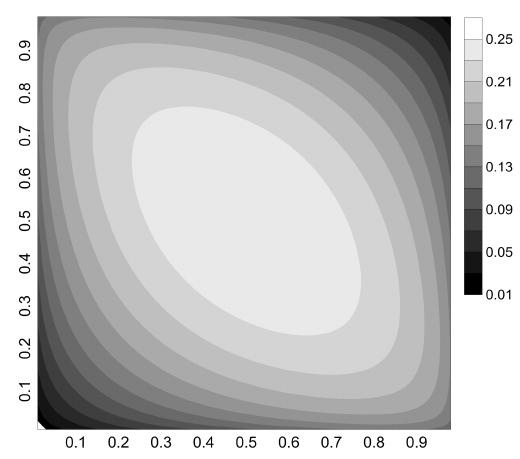
Figure 4. The relationship parameter χ and parameters α , β , where the x axis is parameter α , the y axis is parameter β and the contour is parameter χ